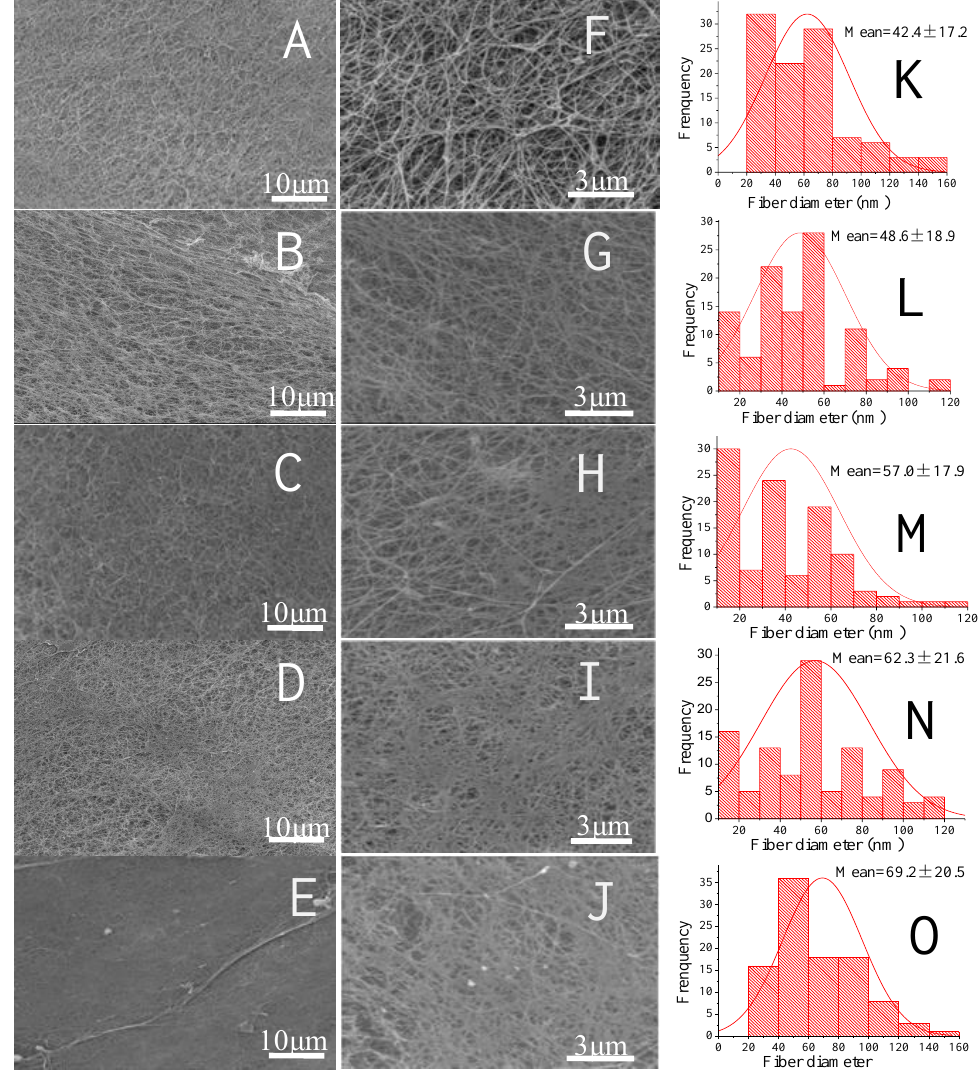
Figure 3. Microstructure and fiber diameter distributions in tube walls of BNC and BNC/Gel composite tubes. SEM images ( A – E ) (5000 × ) and ( F – J ) (20,000 × ) represent the BNC tube, BNC/Gel-0.25, BNC/Gel-0.5 tube, BNC/Gel-1.0 tube and BNC/Gel-2.0 tube. The fiber diameter distribution ( K – O ) is the same as the order of ( A – F ).